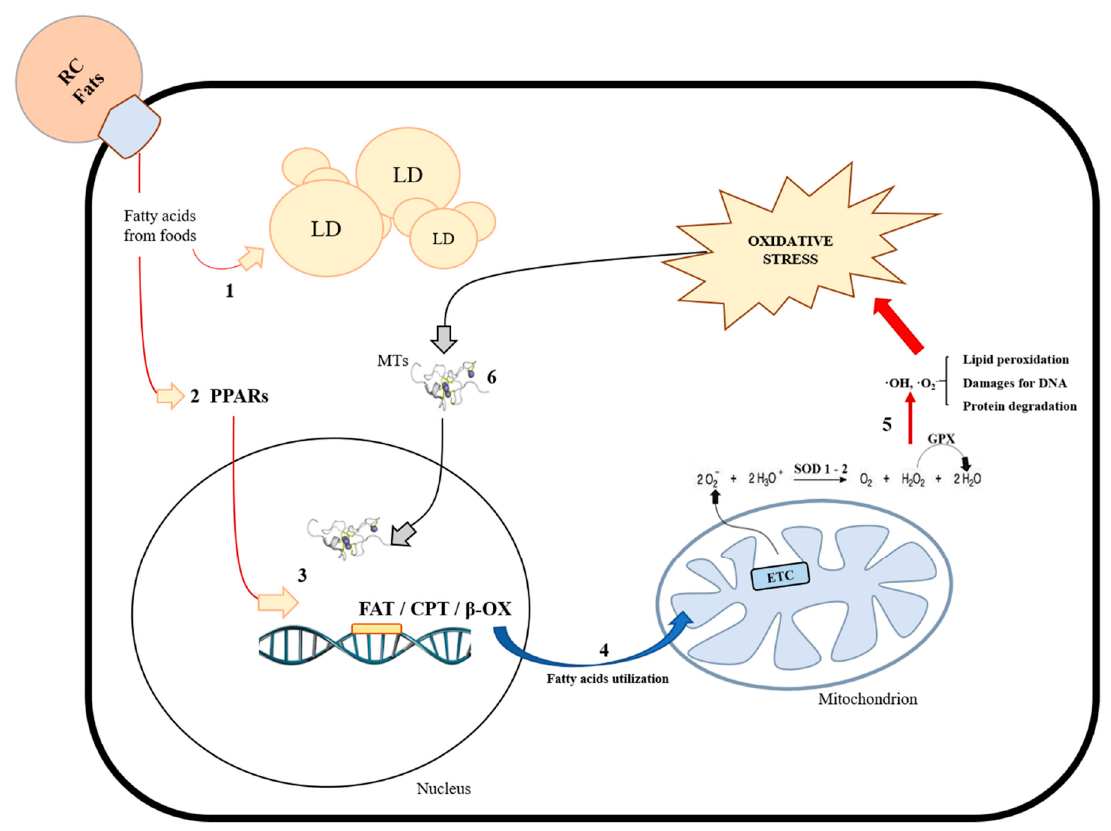
Figure 1. E ff ect of a high-fat diet (HFD) in hepatocytes. Dietary fats reach the liver from the blood vessels by remnant chylomicrons (RC) and enter the hepatocytes. In cell cytosol, elongated fatty acids can be in part accumulated in the form of lipid droplets (1) or used as energetic substrates. PPAR family members (2) play a key role in lipid catabolism activation by inducing the expression of genes (3) involved in the transport and use of fatty acids by mitochondria (4). As a consequence, increased mitochondrial activity produces elevated reactive oxygen species (ROS) levels that, if not adequately counterbalanced by endogenous antioxidant defenses, induce oxidative damage on lipids, proteins, and DNA (5), with negative consequences on the mitochondrial function. Under these metabolic conditions, nuclear transcriptional activity increases to adapt cellular metabolism. Then, MTs localize in the nucleus (6) to donate or chelate metals or to protect DNA from oxidative damage. RC: